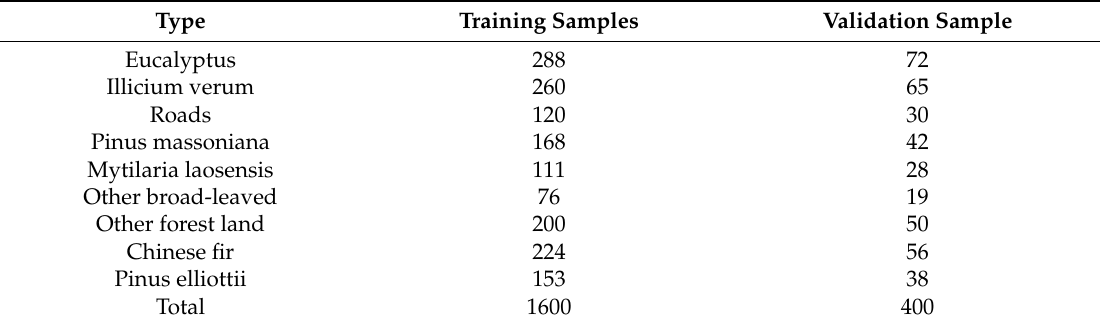
Number of training and validation samples for each tree species category after data